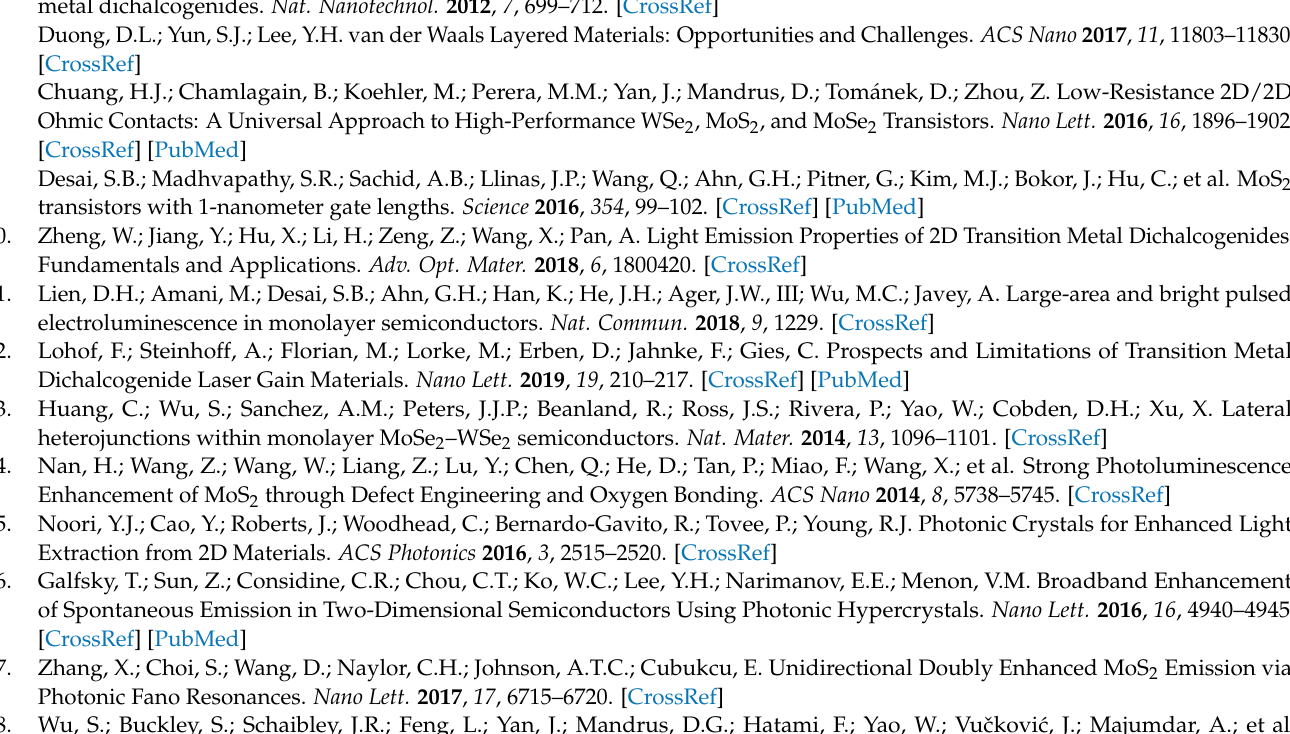
substrate, Figure S2: PL enhancements of MoS 2 with silver ND arrays under different excitations, Figure S3: Measured PL spectra from MoS 2 covering with silver ND arrays with different D and lattice